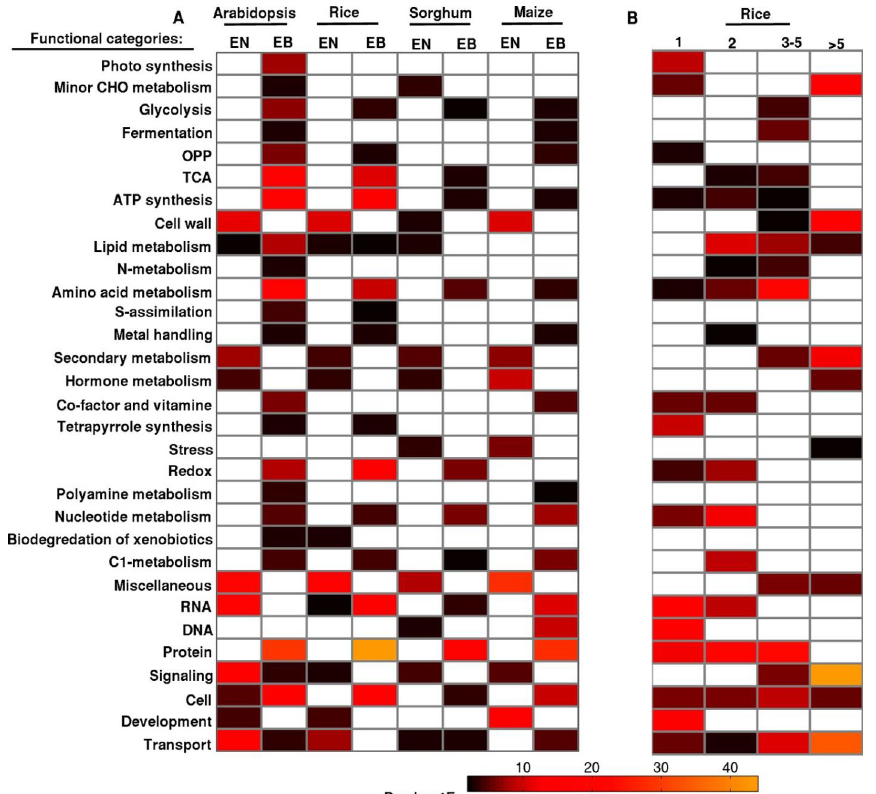
Fig 9. Gene Ontology (GO) enrichment is represented for broadly and narrowly expressed genes. (A) GO terms of broadly expressed (EB) and narrowly expressed (EN) genes are shown for arabidopsis, rice, sorghum and maize. (B) GO term enrichment for biological processes is shown for different size orthologous groups of rice. The functional groups are represented in colors ranging from black through red to yellow based on their increasing significance.